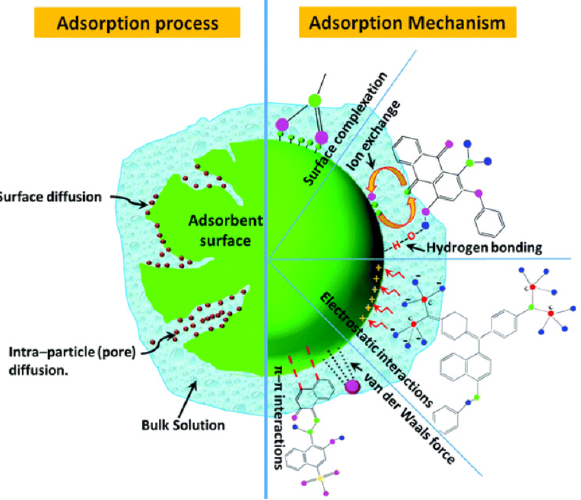
Figure 7. Adsorption processes and mechanisms for dye removal from bulk liquid [123].